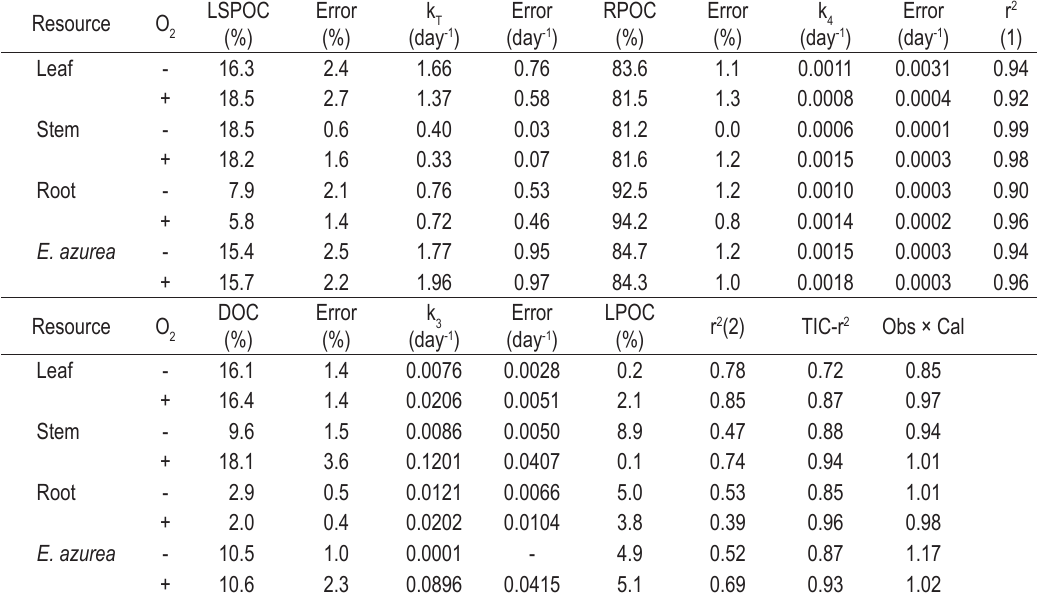
= k + k (k = T 1 2 1 = mineralization rate constant 3